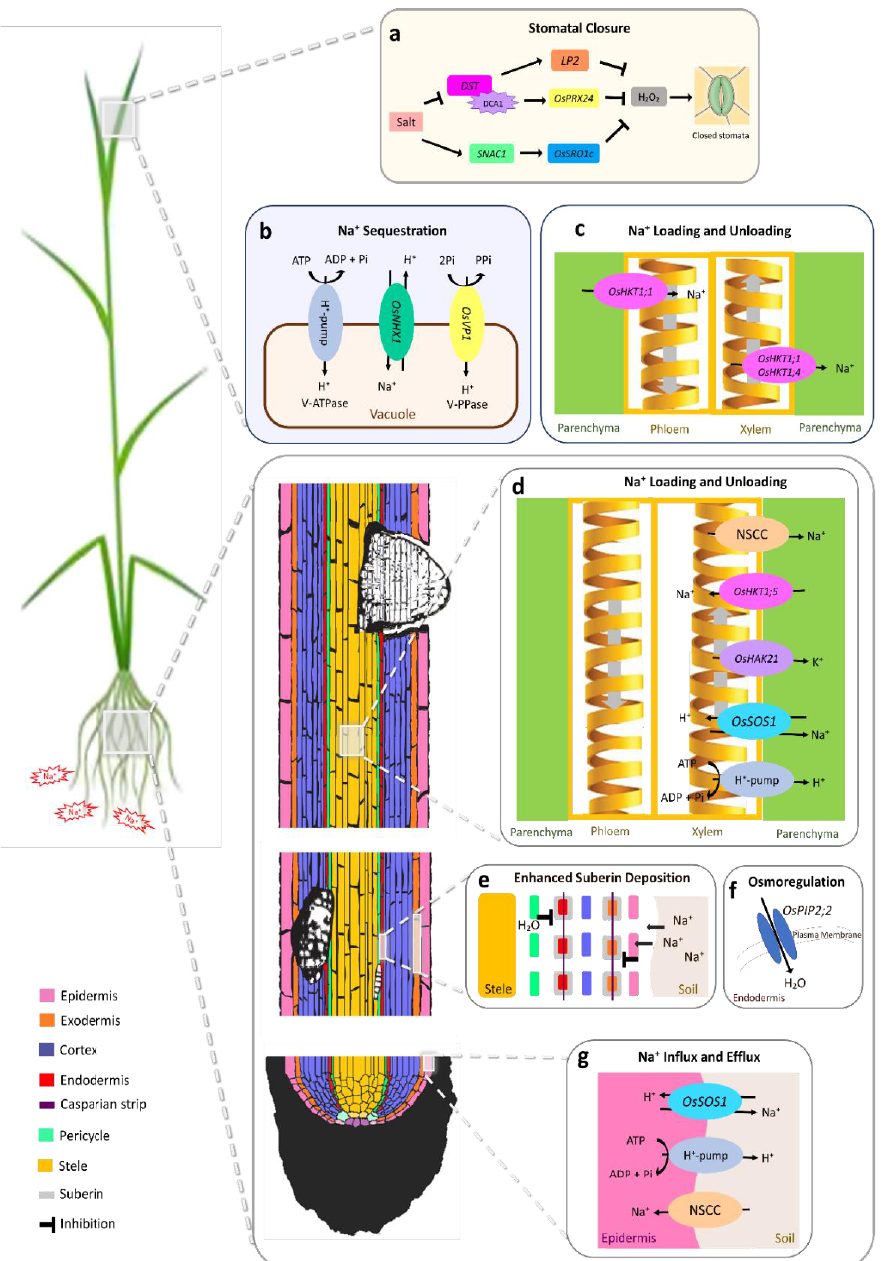
Figure 3. Rice salt tolerance adaptive mechanisms. In the leaf, ( a ) stomatal closure mediated either by DST or SNAC1 is the initial response of rice to salinity. Salt stress downregulates DST which interacts with DCA1 and activates OsPrx24 and LP2 . Conversely, SNAC1 is upregulated, activating the OsSRO1c . These downstream genes mediate stomatal closure via H 2 O 2 inhibition. ( b , c ) Na + content in the leaf cytoplasm is controlled by vacuolar sequestration, xylem unloading, and phloem loading. Excess Na + is sequestered into the vacuole via OsNHX1 coupled with H + -pump and OsVP1 , a vacuolar-type H + -pyrophosphatase encoding gene. Na + unloading at the xylem and Na + loading at the phloem are mediated by OsHKT1;4 and OsHKT1;1 , respectively. In the root, ( d ) Na + is loaded at the xylem through nonselective cation channel (NSCC) and OsSOS1 coupled with H + -pump. Conversely, OsHKT1;5 unloads the Na + ions from the xylem and shuttles them back to the parenchyma cells. Apart from Na + , K + influx occurs mediated by OsHAK21 , thereby increasing the K + /Na + ratio. ( e ) Enhanced suberin deposition in the root exodermis and endodermis also inhibits Na + influx to the stele. Similarly, it blocks water transport out of the stele. ( f ) The plasma membrane-bound OsPIP2;2 gene increases hydraulic conductivity in the root endodermis, allowing water uptake. ( g ) Na + enters the root epidermis via NSCC and is shuttled back to the external medium via the OsSOS1 coupled with H +